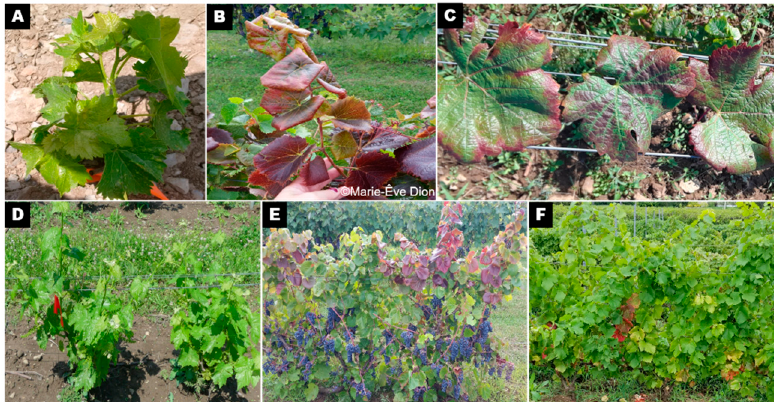
Figure 1. Asymptomatic and symptomatic leaves observed in different cultivars that were positive for grapevine leafroll-associated virus (GLRaV) (GLRaV-2 or 3 or both) in Quebec, Canada. Cultivar Vidal positive to GLRaV without symptom expression ( A , D ), cultivar DM85 positive to GLRaV with leafroll symptom expression ( B , E ) and cultivar Pinot noir positive to GLRaV with leafroll symptom expression ( C , F ).